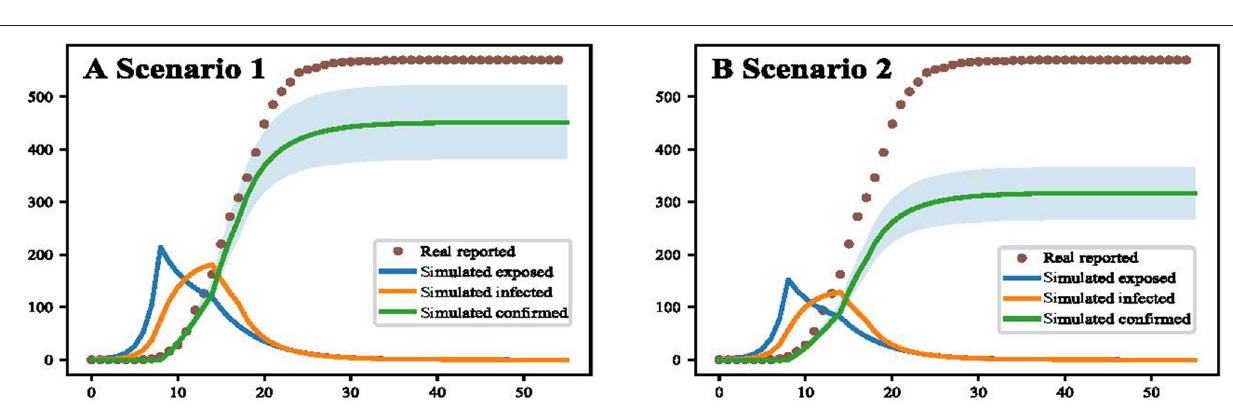
FIGURE 3 | Simulation results of improving vaccination coverage in the elderly (Yangzhou, China, 2021). (A) The result of increasing vaccination coverage to 30 % for people over 60 years. (B) The result of increasing vaccination coverage to 60 % for people over 60